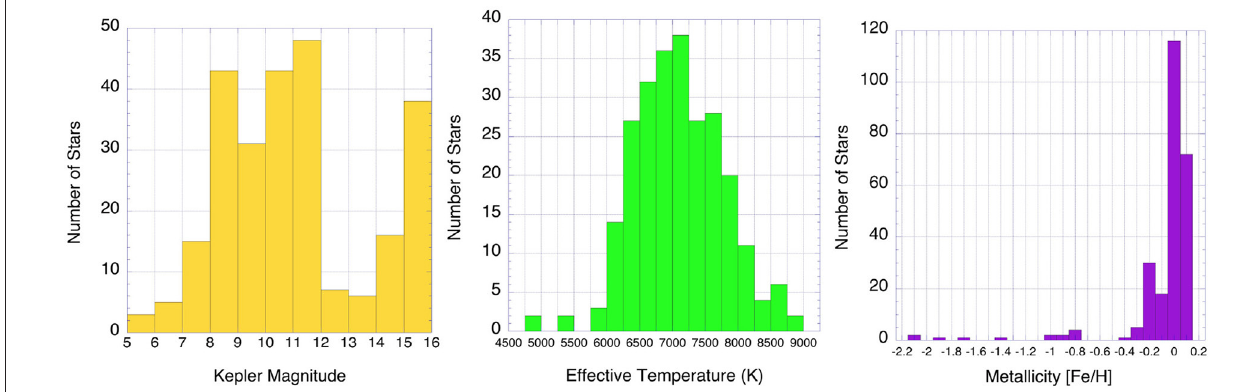
FIGURE 10 | Kp magnitude (Left) , T eff (Center) , and metallicity [Fe/H] (Right) distributions of 249 δ Sct candidates, based on EPIC catalog quantities.